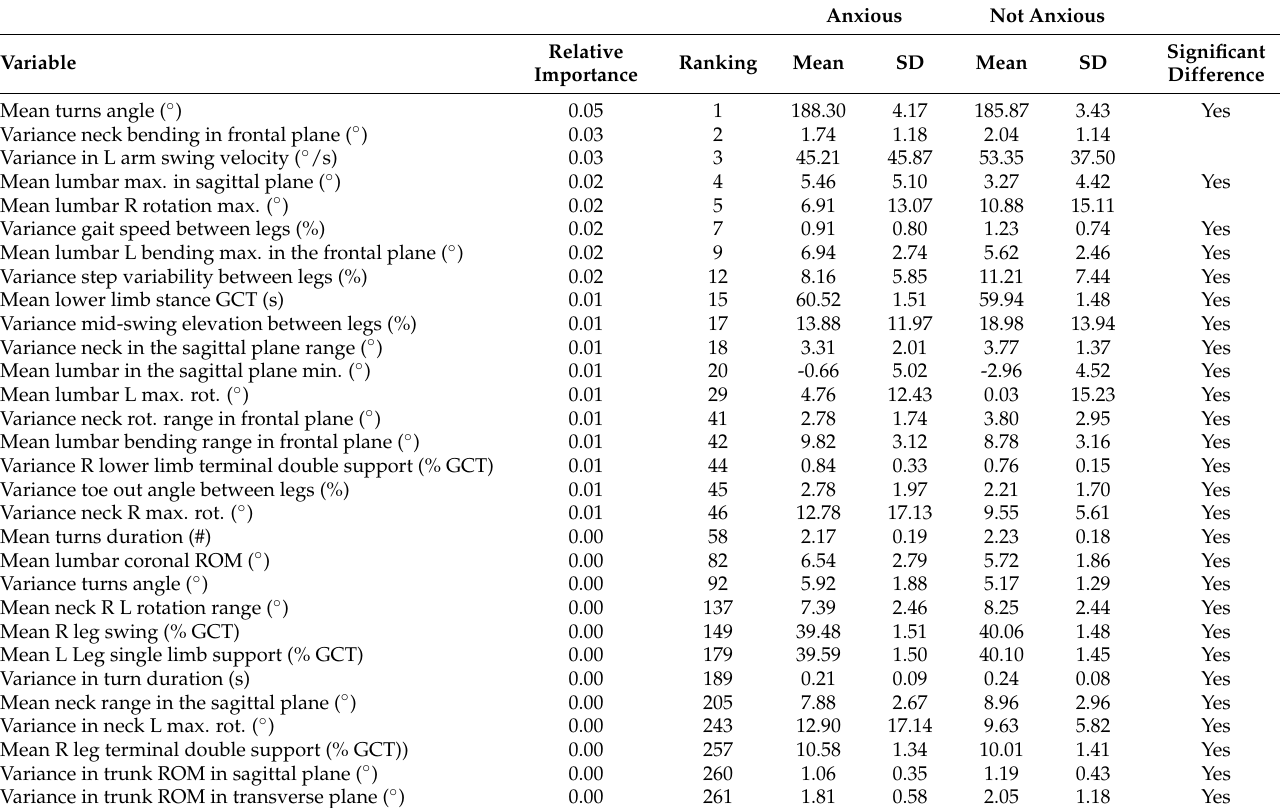
Table 1. Top 5 Variables and Significant Gait Variables